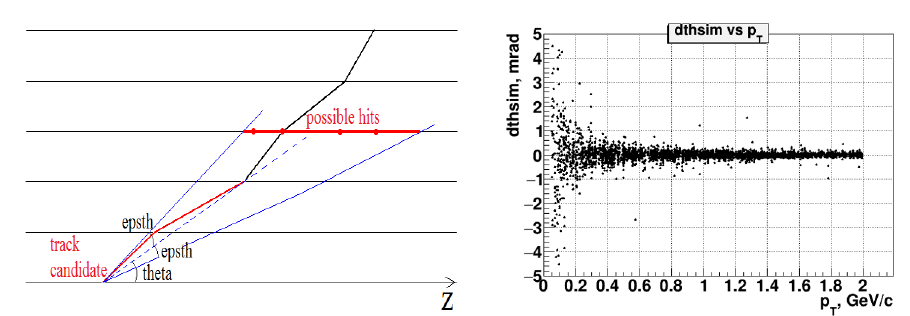
Figure 4. Left) Track scheme in longitudinal projection; right) longitudinal angle di ff erence as a func- tion of p T . Broadening of the distribution towards low p T is caused by the multiple scattering of tracks in the detector material